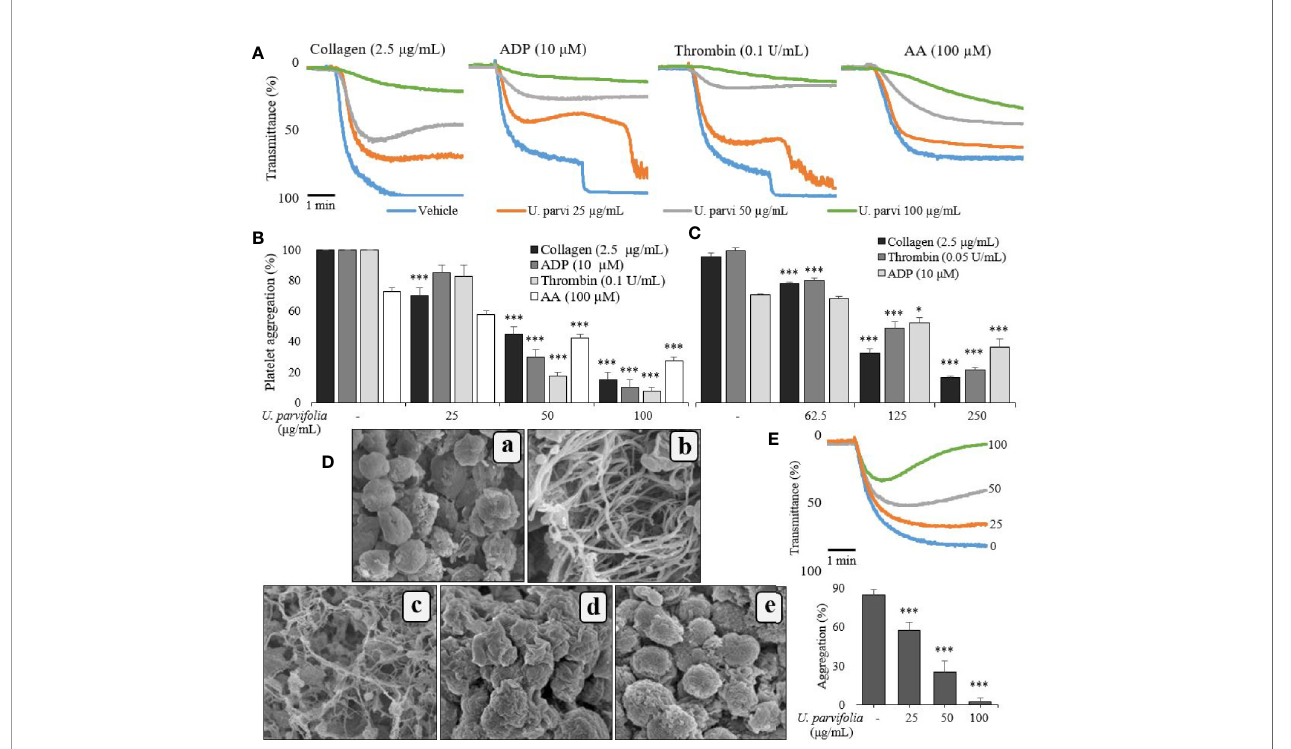
FIGURE 1 | U. parvifolia inhibits agonist-induced human and rat platelet aggregation. Collagen-, ADP-, arachidonic acid (AA), or thrombin-stimulated washed platelets (A, B, D, E , from rats; C , from humans) pre-treated with vehicle or various U. parvifolia extract concentrations in the presence of 1-mM CaCl 2 . (D) Representative SEM images (5,000×) of collagen (2.5 µg/ml)-stimulated platelets pre-treated with vehicle or various U. parvifolia extract concentrations [(a) Resting, (b) Vehicle, (c) 25 µg/ml, (d) 50 µg/ml, (e) 100 µg/ml]. (E) Rat PRP was incubated with vehicle or various concentrations of extract in the presence of 10-mM CaCl 2 for 1 min and then stimulated with ADP (25 µM) for 5 min. The graphs show mean ± SD values from at least four independent experiments. * p < 0.05 and *** p < 0.001 versus